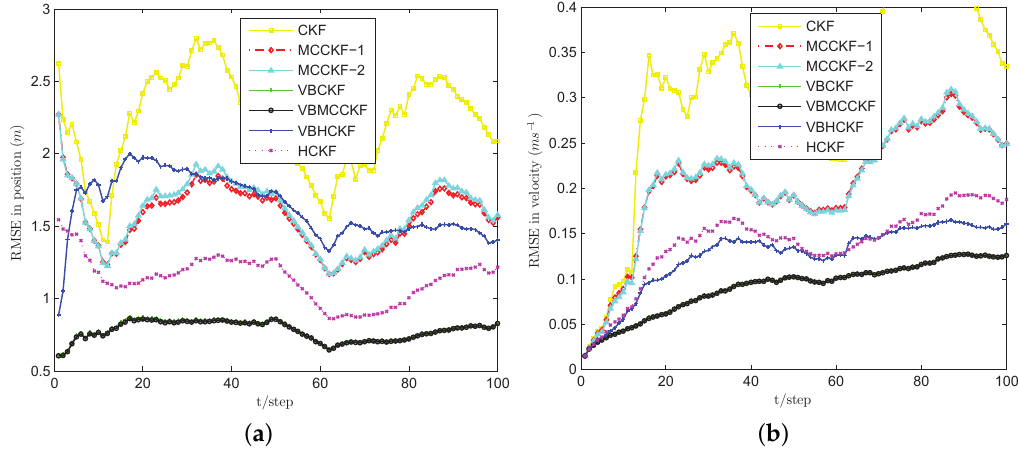
Figure 4. RMSE performances of different filters under Case C. ( a ) Position; ( b )